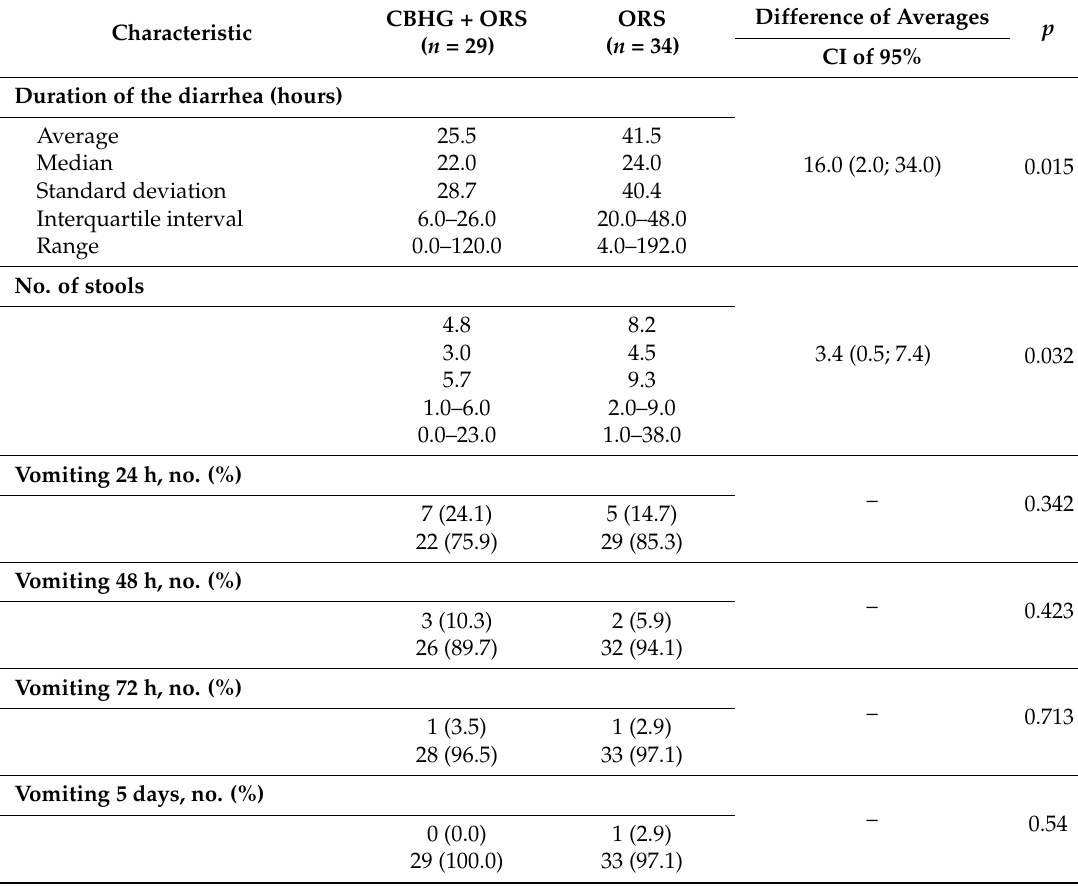
Table 2. Variables observed after the treatment according to study